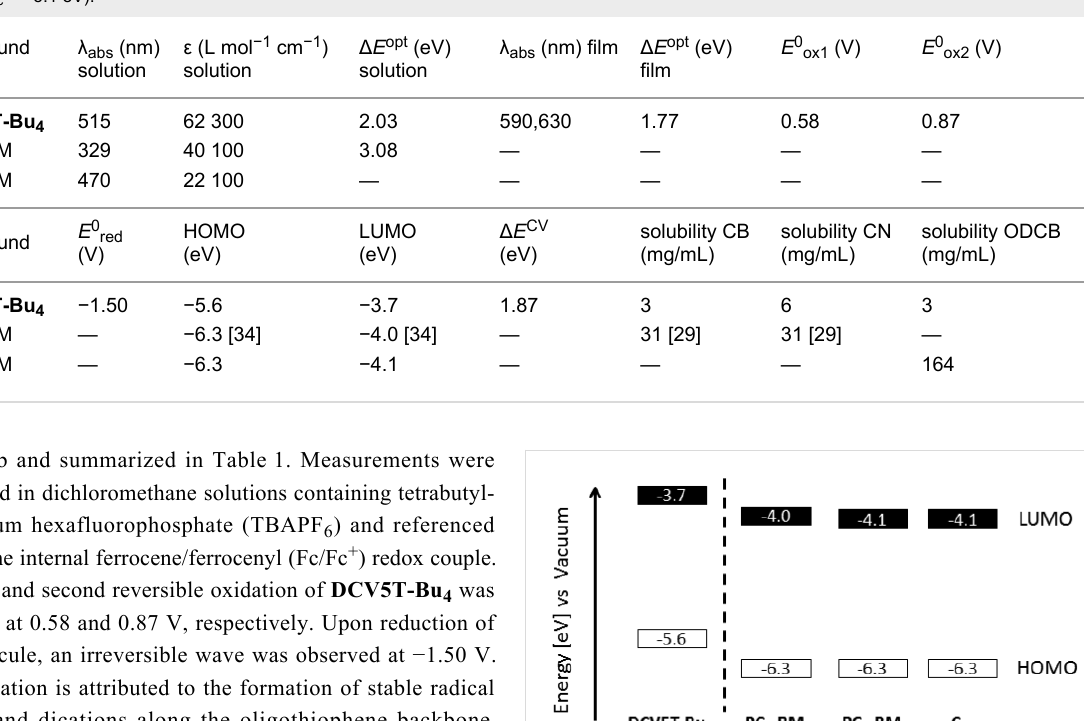
Table 1: Optical, electrochemical, and maximum solubility data for DCV5T-Bu 4 , fullerene PC 61 BM, and PC 71 BM. Absorption spectra measured in CHCl 3 , thin films spin-coated from chlorobenzene at 80 °C and electrochemical measurements in CH 2 Cl 2 /TBAPF 6 solutions (HOMO/LUMO vs Fc/Fc + vac = − 5.1 eV).